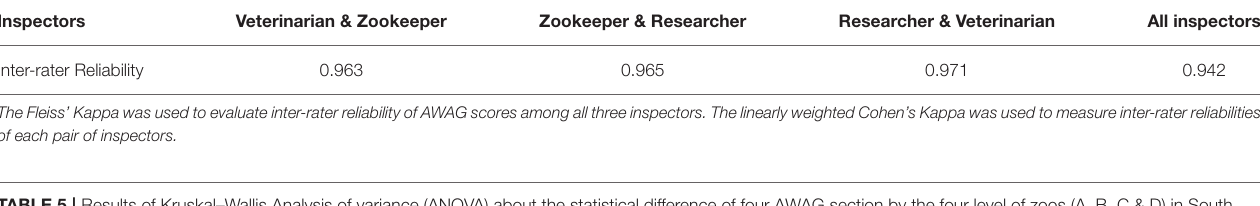
TABLE 4 | Inter-rater reliability (IRR) between each pair of inspectors and all three inspectors.